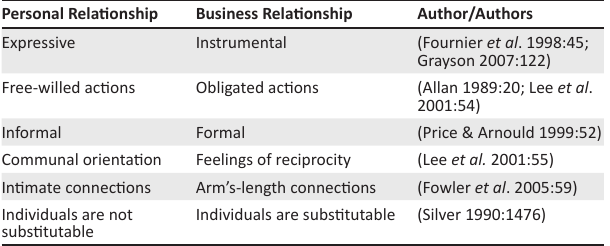
TABLE 1: Differences between personal and business